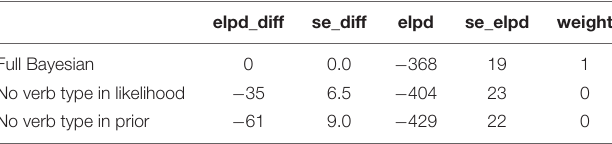
The table is ordered by the expected log-predictive density (elpd) score of the models, with a higher score indicating better predictive accuracy. The highest scoring model is used as a baseline for the difference in elpd (elpd_diff) and the difference standard error (se_diff). “Weight” represents the weights of the individual models that maximize the total elpd score of all the